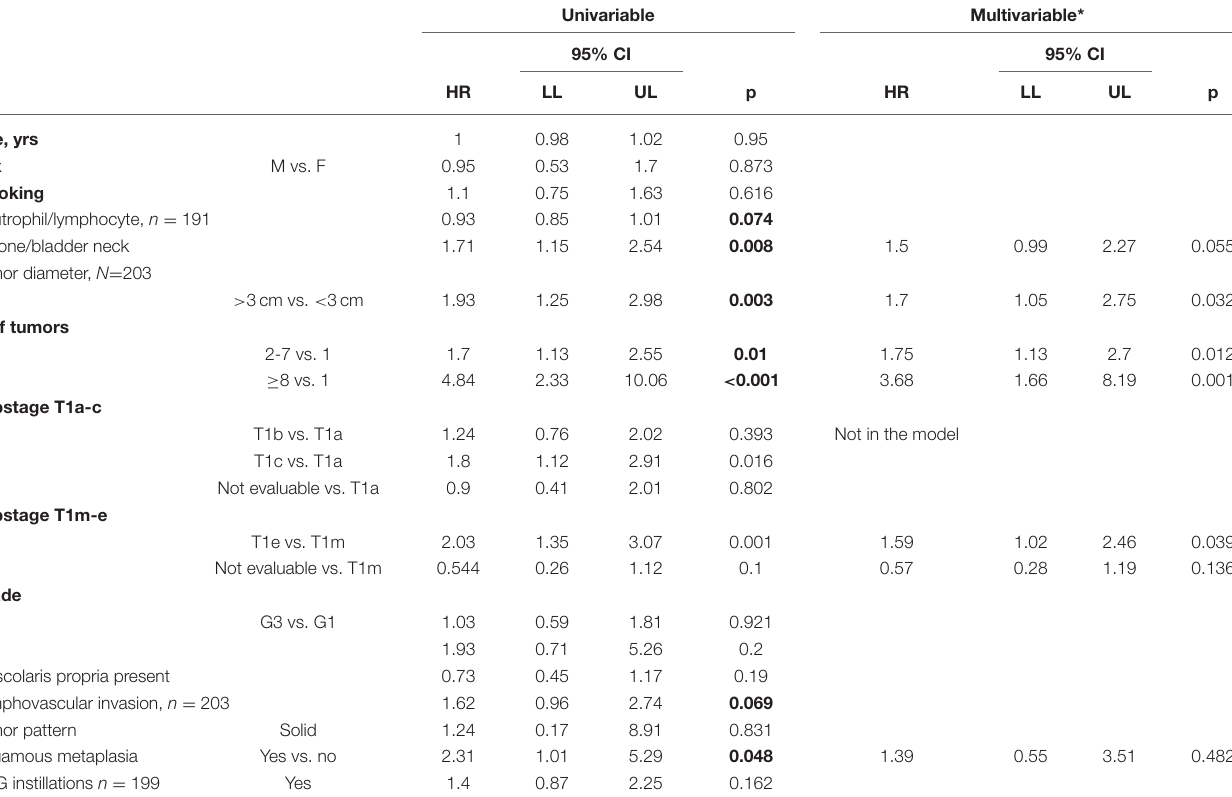
TABLE 6 | Uni and multivariable Cox regression model was performed to evaluate which independent variables influence the recurrence. Univariable